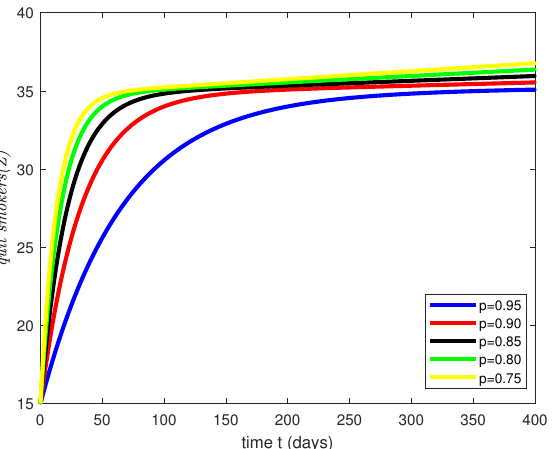
Figure 5. Adaptive nature of the approximated result for the quitter smokers Z ( t ) class of the considered model at different arbitrary fractional orders.